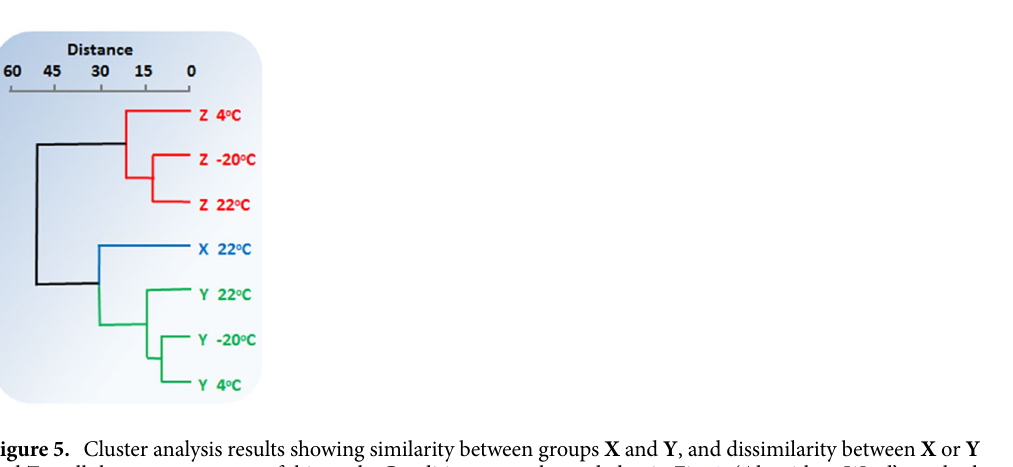
Table 1. Results of a post hoc test conducted to determine exact pairs of experimental conditons with significant mean difference. Tukey’s Q below the diagonal, p (same) above the diagonal. Z is the reference samples; Y is the reference samples analyzed again after 36 days of incubation at different temperature. Z samples are Y with no internal standards until day 36. a Significant difference.